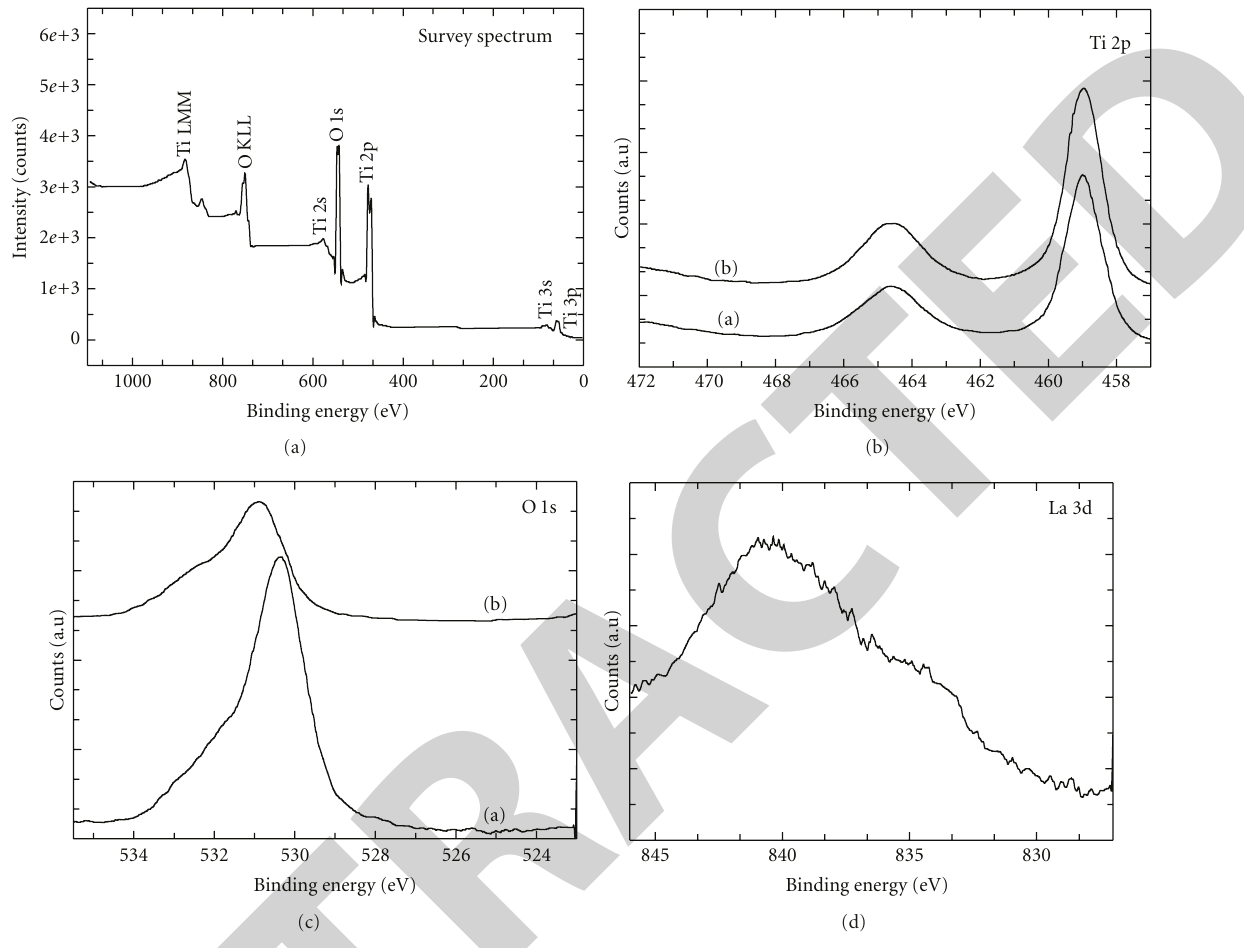
Figure 7: XPS spectra of pure and 1.0 wt% La-doped TiO 2 : (a) survey spectrum of TiO 2 (b) Ti 2p (a = TiO 2 ; b = 1.0wt% La-TiO 2 ) (c) O 1s (a = TiO 2 ; b = 1.0 wt% La-TiO 2 ), and (d) La